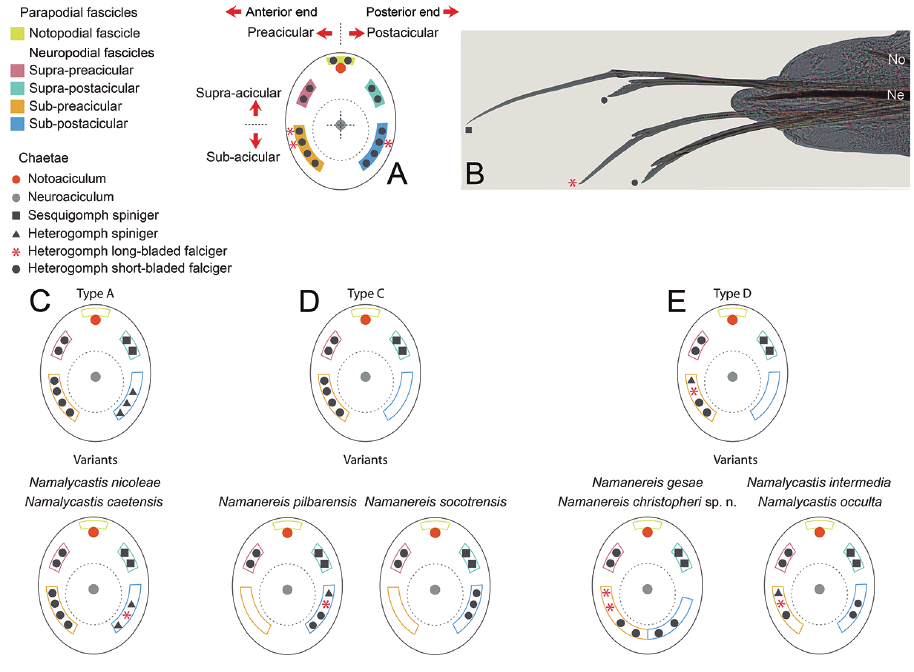
Figure 6. Chaetal arrangement of some namanereidins referred in this study. A Scheme showing the parapodial fascicles and their positions in relation to neuroaciculum B Neuropodial lobe of right parapo- dium from chaetiger 10 of Namalycastis occulta , showing the position of chaetae in type D species when mounted C–E Chaetal arrangement of types A, C and E, and their variants found in literature (modified from Glasby 1999, Fig.